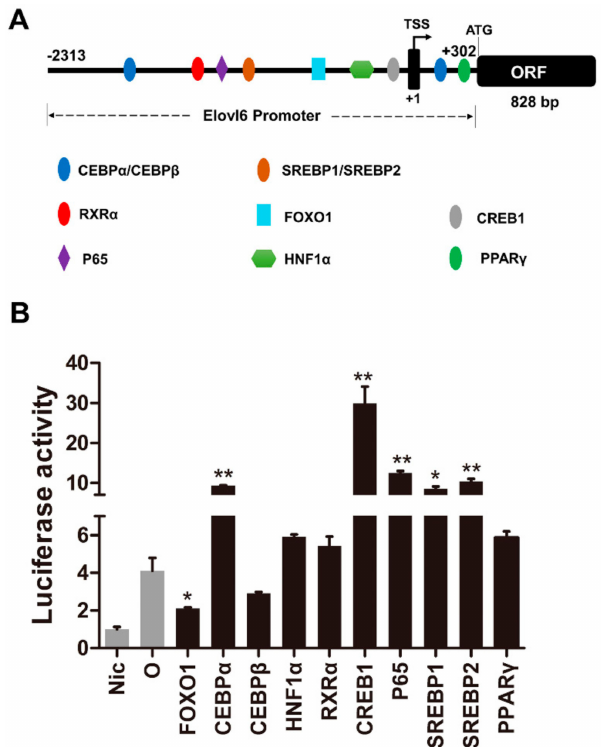
Figure 7. The transcription factors sites ( A ) and e ff ects on the elovl6 promoter ( B ) of rainbow trout in HEK 293T cells. The negative control Nic (pGL3-basic) was an empty plasmid with no promoter sequence. TSS: transcriptional start site. The promoter was co-transfected with plasmids of transcription factors FOXO1; CEBP α ; CEBP β ; HNF1 α ; RXR α ; CREB1; P65; SREBP1; SREBP2; and PPAR γ , compared with the control group (O) which transfected with pGL3- elovl6 promoter only, respectively. The luciferase activity in the Nic group was selected as normalization. Data were presented as means ± S.E.M. (n = 3). * p < 0.05; ** p <